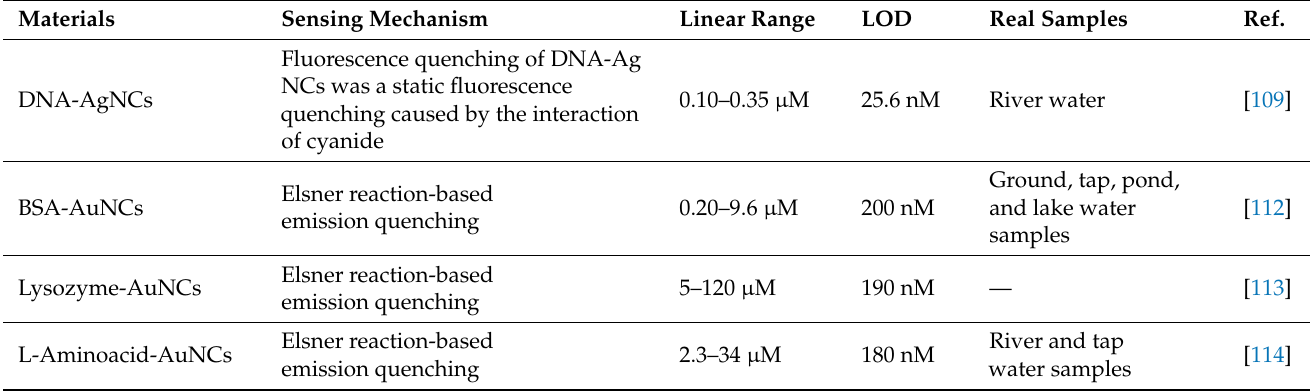
Table 2. Analytical parameters of metal nanoclusters-based fluorescence